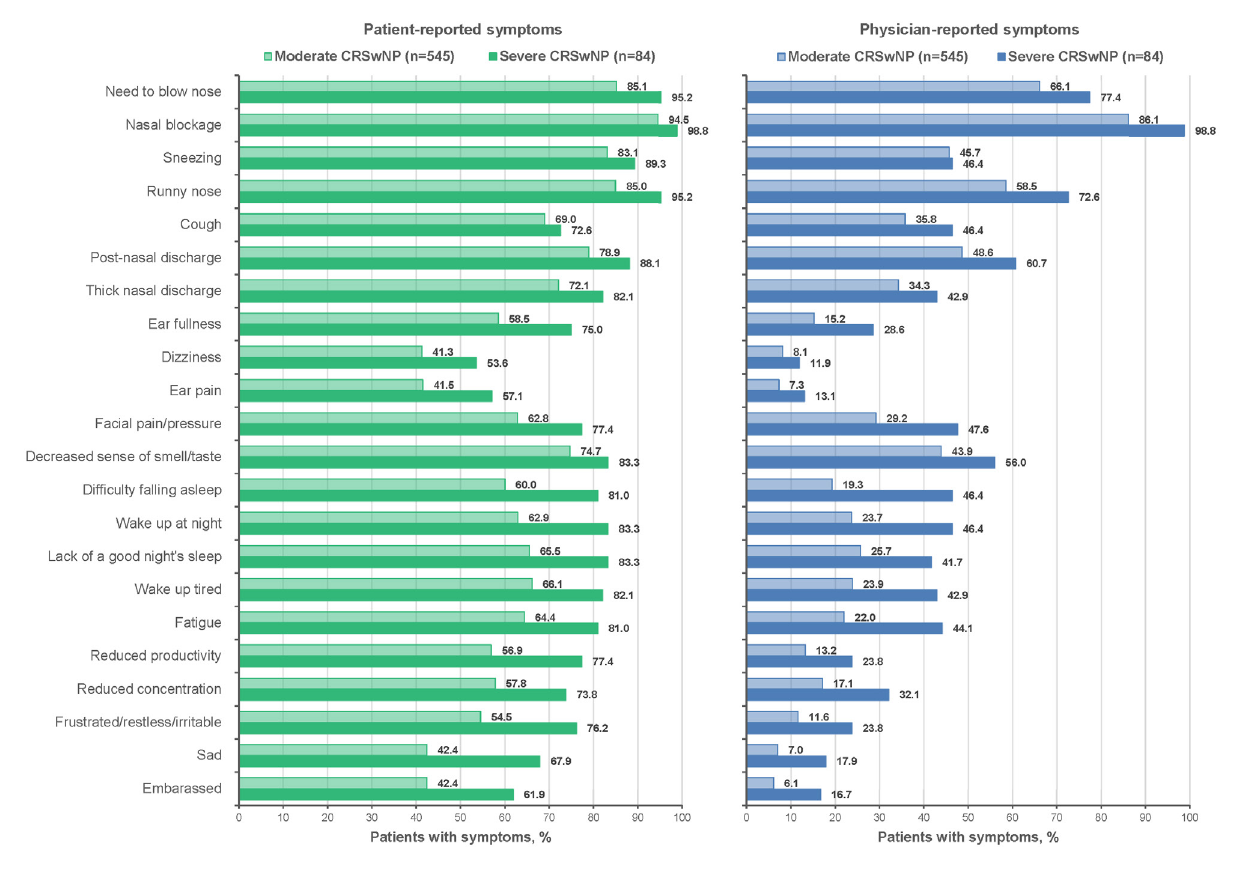
Figure 3. Prevalence of reported CRSwNP symptoms from matched patient/physician perspectives by categories of CRSwNP severity a (consecutive sample). a CRSwNP severity determined by physician for each patient based on physician’s clinical expertise and provided guidance to follow the European Position Paper on Rhinosinusitis and Nasal Polyps guidelines (2,10) and NP size scoring systems. Abbreviations: CRSwNP, chronic rhinosinusitis with nasal polyposis; NP, nasal